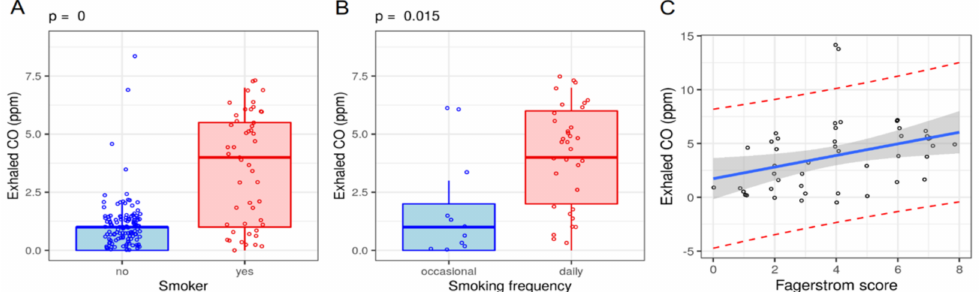
Figure 1. Dependency of exhaled CO on ( A ) smoking status, ( B ) smoking frequency, and ( C ) Fager- ström